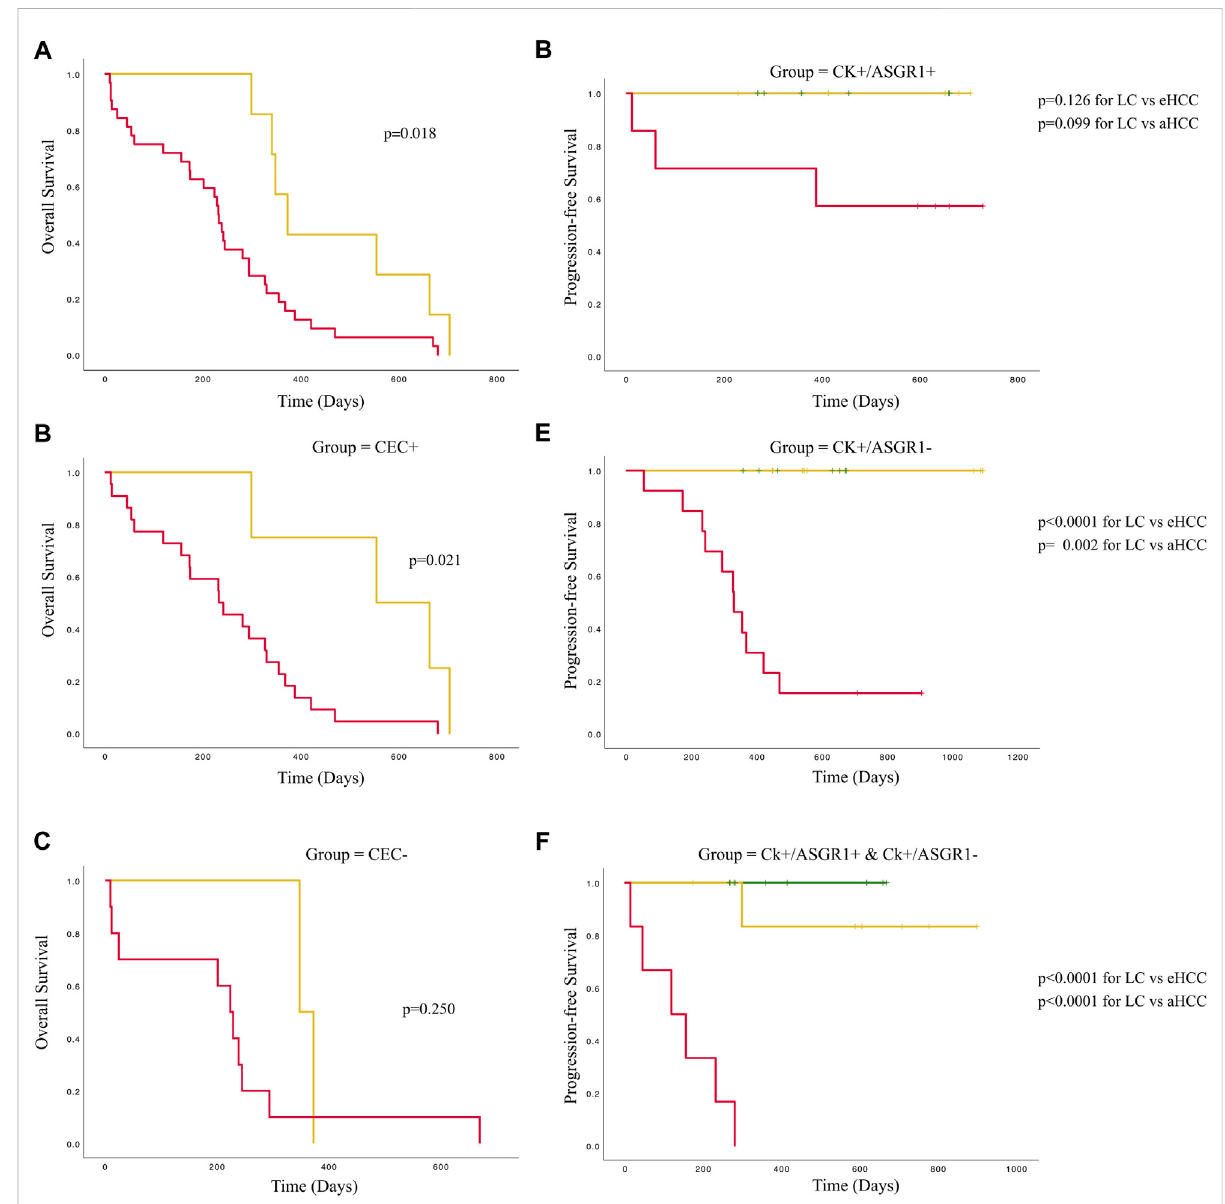
FIGURE 6 Survival curves for patients with liver cirrhosis or HCC accounting for CEC numbers and phenotype. Left part of the fi gure represents overall survival curves for the whole population (A) , only for those positive for CECs (B) and for those negative for CECs (C) . Colors are Grey = eHCC and Black: aHCC. Right part of the fi gure represents progression-free survival for patients with all CECs positive for ASGR1 (D) , patients with all CECs negative for ASGR1 (E) and patients with heterogeneous CEC phenotypes (F) . Colors are: Dotted Grey = liver cirrhosis; Grey eHCC and Black: